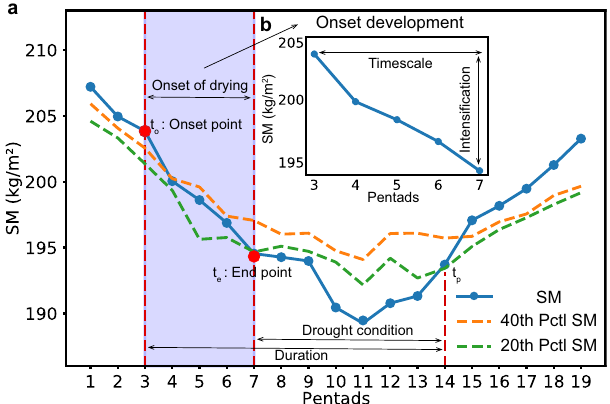
Fig. 5 Schematic representation of the method used to identify a fl ash drought event. a Schematic representation of the whole phase of a fl ash drought event. SM decreases from above the 40th percentile to below the 20th percentile with an average decline rate of no less than the 5th percentile for each pentad, and SM below the 20th percentile should last for no less than 3 pentads. The blue solid line represents the 5-day mean SM percentile for a grid point. The orange and green dashed lines represent the wet (the 40th percentile at a particular time of the year during the period 2000 – 2020) and the dry (the 20th percentiles at a particular time of the year during the period 2000 – 2020) conditions of SM, respectively. The purple shaded area represents the onset development of fl ash droughts. b Schematic representation of the onset phase of a fl ash drought